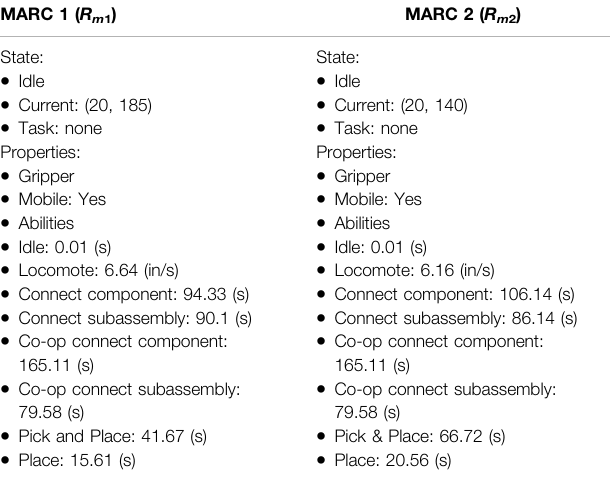
TABLE 4 | SAPD robot de fi nitions for the arch assembly